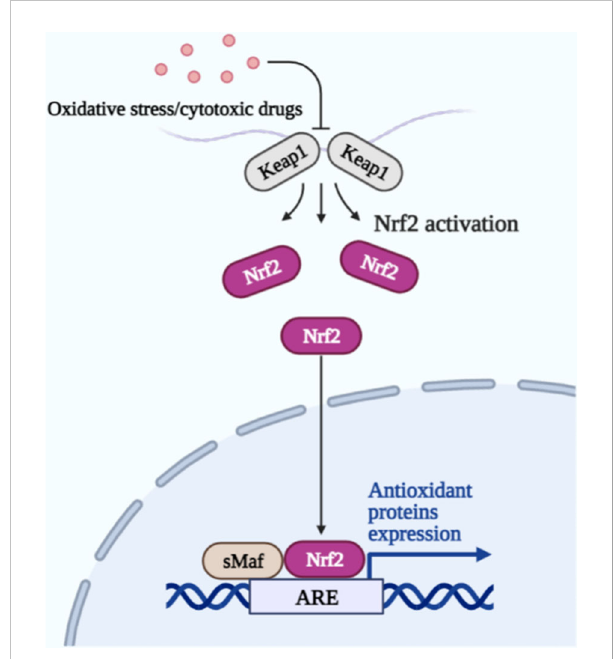
FIGURE 2 Upon oxidative stress or cytotoxic drug stimulation, Keap1 is separated from Nrf2, and Nrf2 is activated. Together with the sMaf protein in the nucleus, it binds to the antioxidant response element (ARE) and drives the expression of antioxidant protein genes to protect